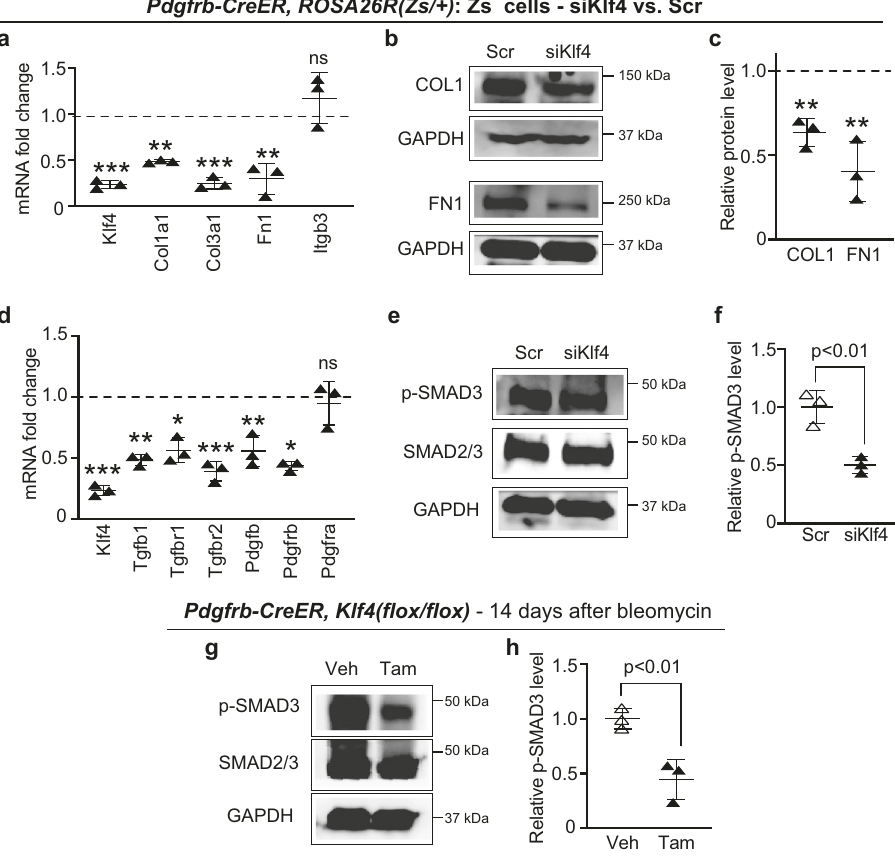
Fig. 3 Klf4 deletion in PDGFR- β + cells attenuates bleomycin-induced myo fi broblast accumulation and lung fi brosis. a – e Pdgfrb - CreER T2 , Klf4 ( fl ox/ fl ox) mice were induced with either vehicle (Veh; corn oil) or tamoxifen (Tam), rested and treated with bleomycin. Lungs were analyzed 14 days later. Cryosections were stained for SMA and nuclei (DAPI) in ( a ) and with Picrosirius red ( b ) with dashed boxes shown as close-ups on the right. Closed arrowheads and asterisks indicate SMA + fi brotic patches and blood vessels, respectively. n = 3 mice for vehicle and n = 6 mice for tamoxifen inductions. Collagen content of the right lung was measured using the Sircol assay ( c ); n = 3 mice in duplicate, p = 0.001. Western blot analysis of lung lysates for SMA, collagen 1 (COL1), fi bronectin (FN1) is shown in d with densitometric analysis relative to GAPDH and normalized to vehicle ( e ). n = 3; **, ***, **** vs. vehicle, p = 0.0086, p = 0.0003, p < 0.0001, respectively. f – i Pdgfrb-CreER T2 , ROSA26R (YFP/ + ) mice carrying Klf4 ( fl ox/ fl ox) or wild type for Klf4 were induced with tamoxifen, rested, treated with bleomycin and lungs were analyzed 14 days later. Mice were injected with EdU 12 h prior to euthanasia. Lung cryosections were stained for YFP (fate marker) and nuclei (DAPI) as well as for EdU ( f ) or SMA ( h ) with boxed regions shown as close-ups on the right. Open arrowheads indicate YFP + cells that are also EdU + ( f ) or SMA + ( h ). The percentage of YFP + cells that are EdU + or are SMA + myo fi broblasts was quanti fi ed in g and i , respectively. ns not signi fi cant. For each genotype, we analyzed n = 3 mice, three sections per mouse, and on average 41 YFP + cells ( g ) or 68 myo fi broblasts ( i ) per section. Two-tailed Student ’ s t test was used for all analysis. Data are averages ± SD. Source data are provided as a Source